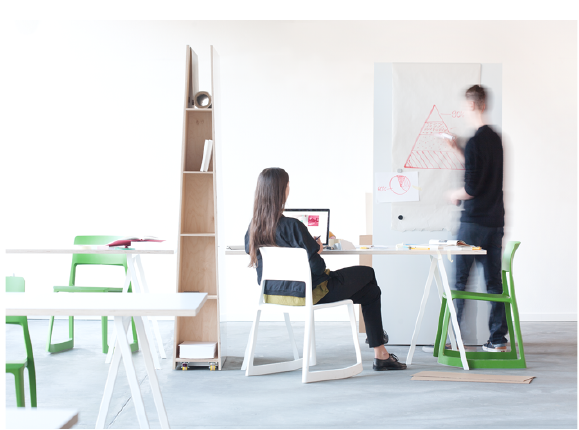
Fig. 7. Final furniture concept: storage-whiteboards (photo ©Robin Stummvoll, used with permission from Tim Mackerodt